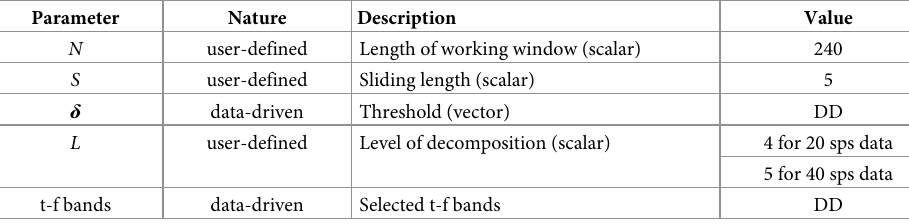
Table 1. List of parameters used by the algorithm with brief description and values used in the